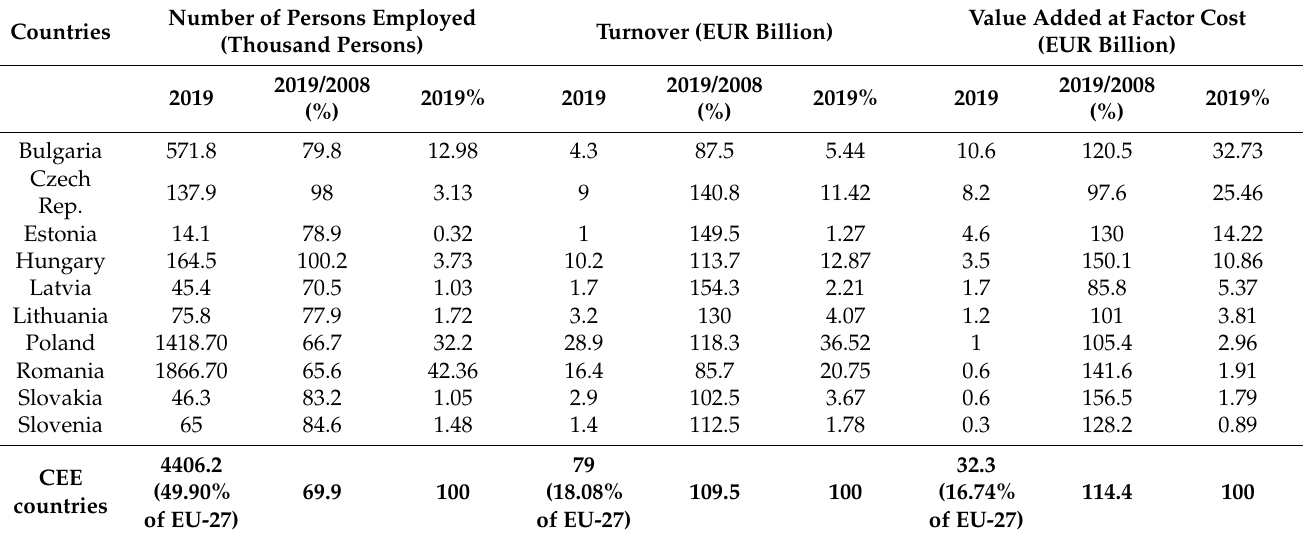
Table 3. Numbers of persons employed, turnover, and value added at factor cost—agriculture based bioeconomy sector.